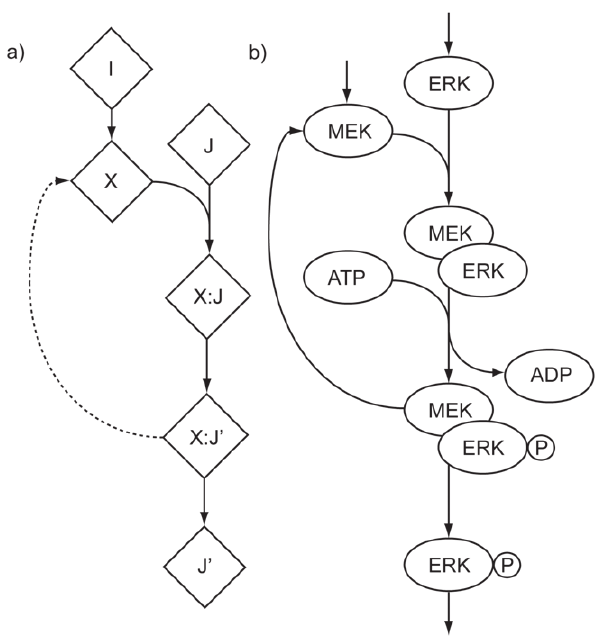
Figure 2. Logical loop structure, with an example from Reactome. a) An example of a logical loop structure. There exist two satisfying assignments to this set of statements when J’ is set to 1 - one with all variables except I set to 1, and one with all variables set to 1. To exclude the former solution from the solution space, the statement describing the relationship represented as a dashed line is removed from the logical formulation. b) In one mechanism of ERK phosphorylation, MEK and ERK are activated by various upstream processes (inputs). These active signals then form a complex, with MEK acting as a catalytic subunit of the complex resulting in ERK phosphorylation. The complex dissociates post-phosphorylation to yield phosphorylated ERK and MEK. Conversion to the logical form of this reaction yields a set of logic statements with associated SCC that has topology similar to a)